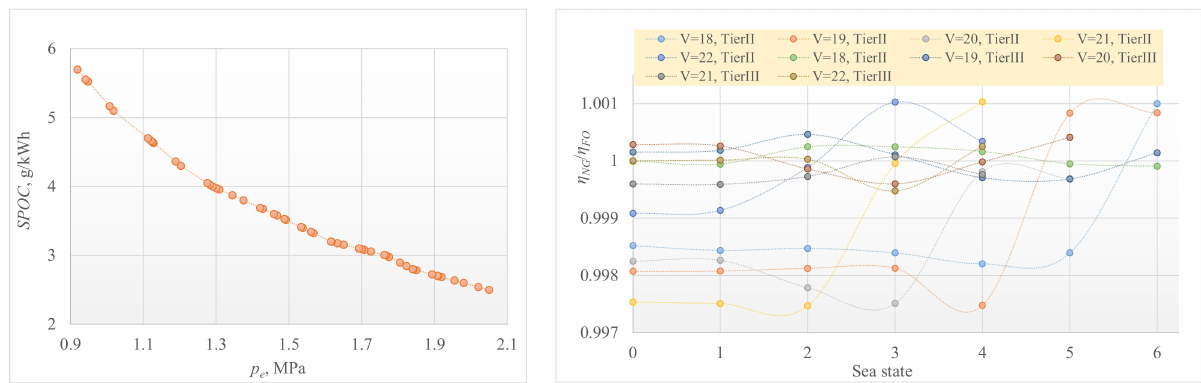
Figure 12. The engine energy efficiency in the FO ( left ) and NG ( right ) fueling modes for Tier II and Tier III modes at various SI S and V S .